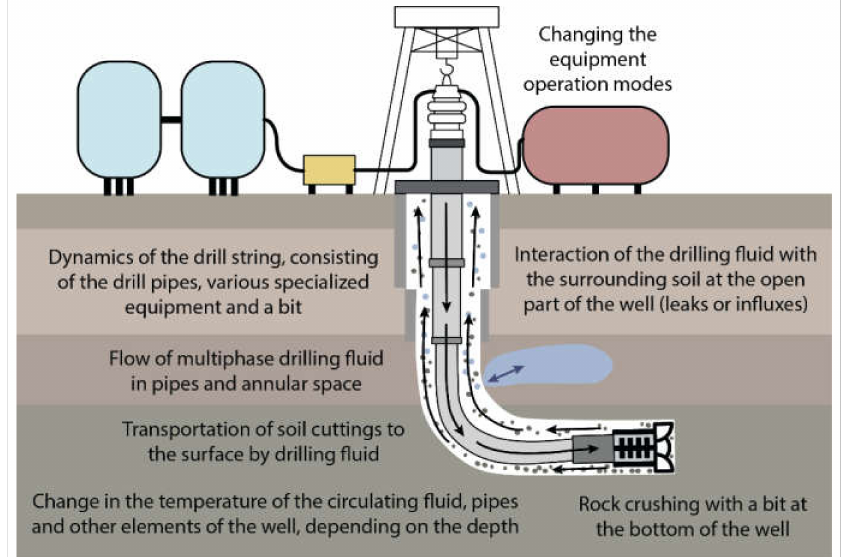
Figure 1. The drilling process scheme. The drilling bit interacting with the rock is located at the bottom of the drill